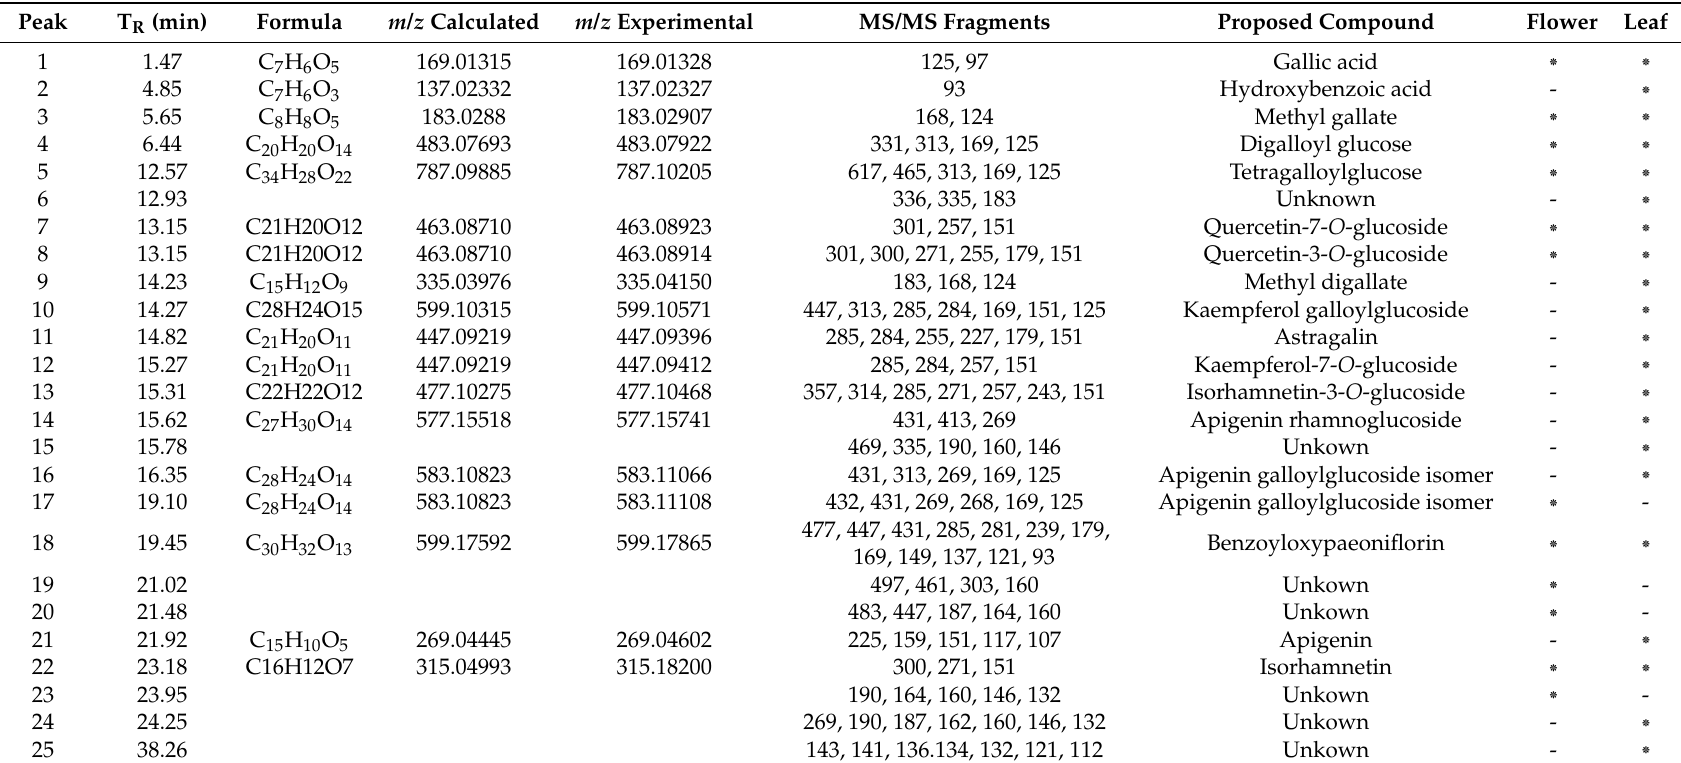
Table 4. List of partially-identified antioxidant compounds from the flowers and leaves of Paeonia rockii by UHPLC-ESI-HRMS n